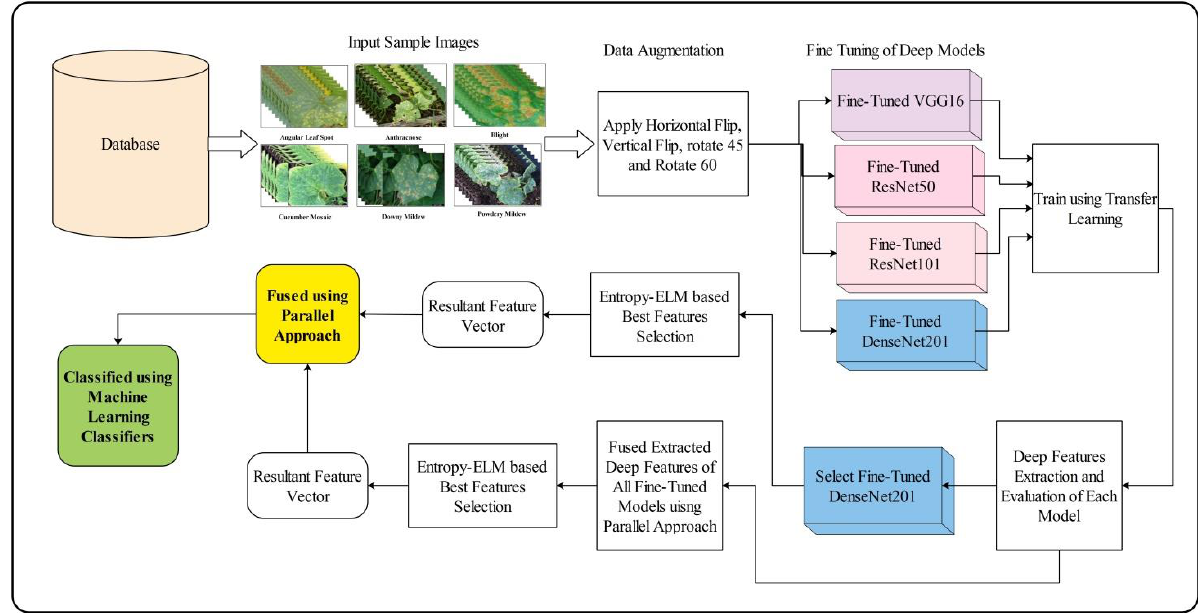
Figure 1. Proposed framework for cucumber leaf diseases recognition using deep learning and Entropy-ELM.